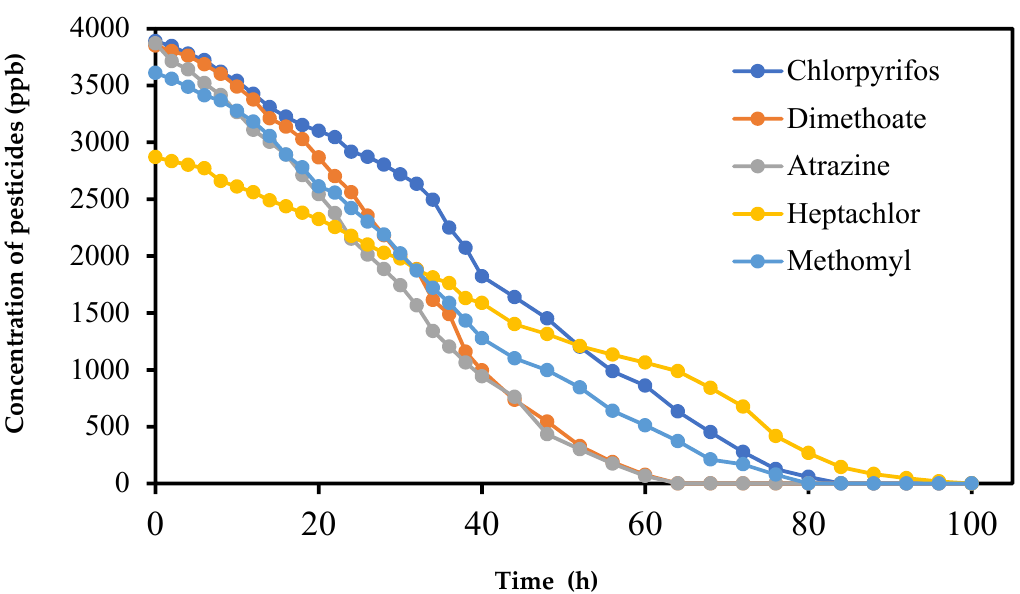
Figure 2. Variation of the concentration of the pesticides as a function of time under UV irradiation in absence of photocatalysts.